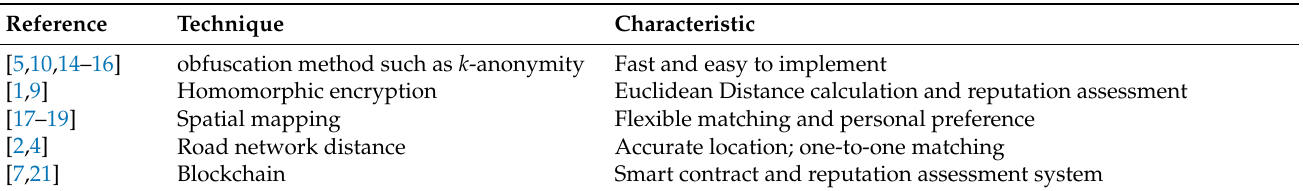
Table 1. Summary of privacy-preserving schemes that address location